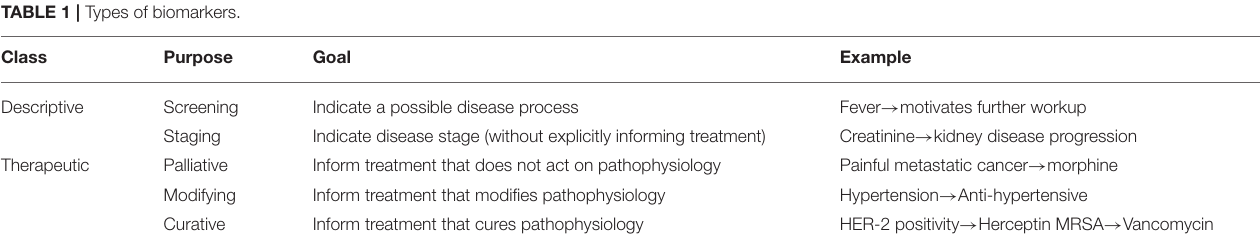
TABLE 1 | Types of